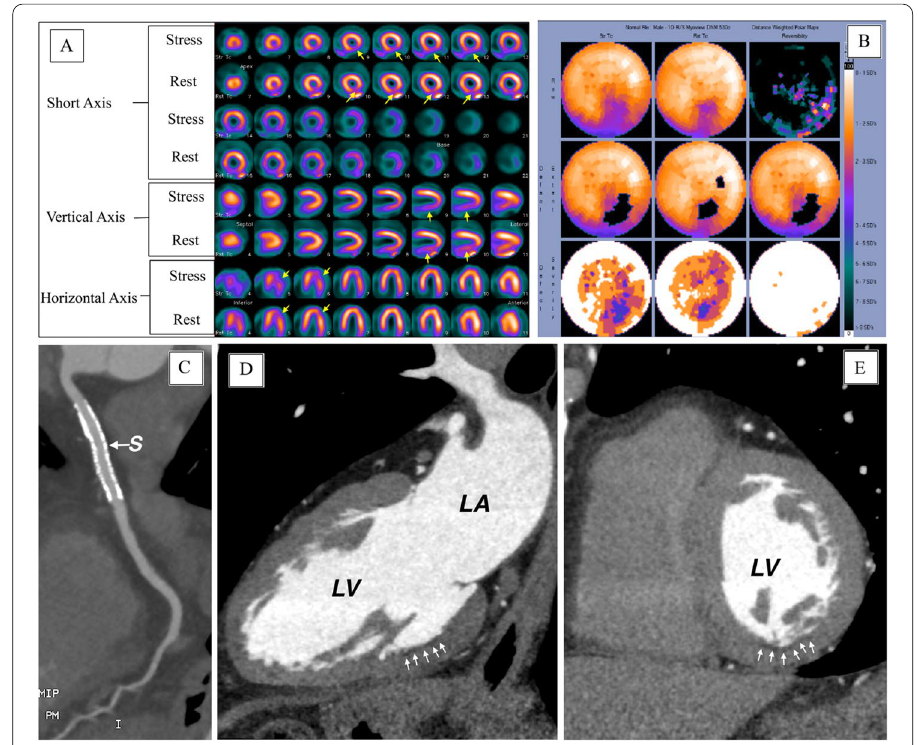
Fig. 1 A SPECT images, B polar maps at stress (upper panel) and rest (lower panel), C – E computed tomographic angiography images. LV, left ventricle; LA, left